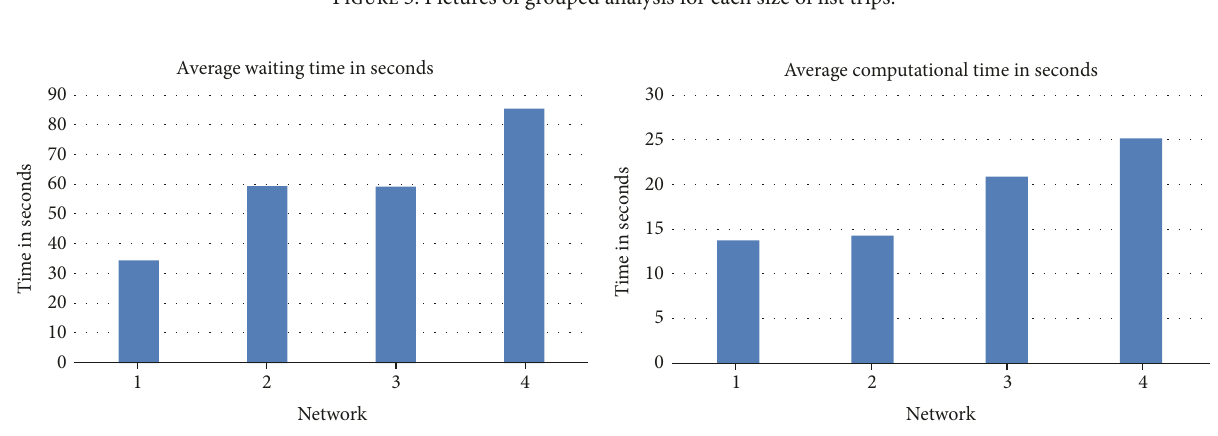
Figure 5: Pictures of grouped analysis for each size of list trips.